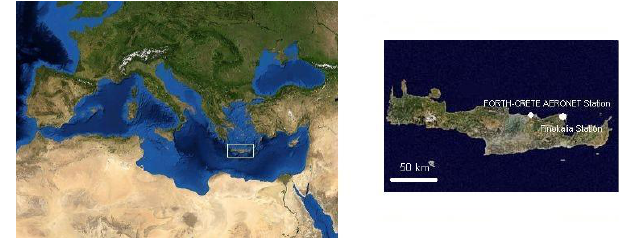
Fig. 1. The Mediterranean basin and the sites of FORTH-CRETE AERONET and Finokalia Stations, on the island of Crete. Table 1. Input data required to model the shortwave radiation bud-